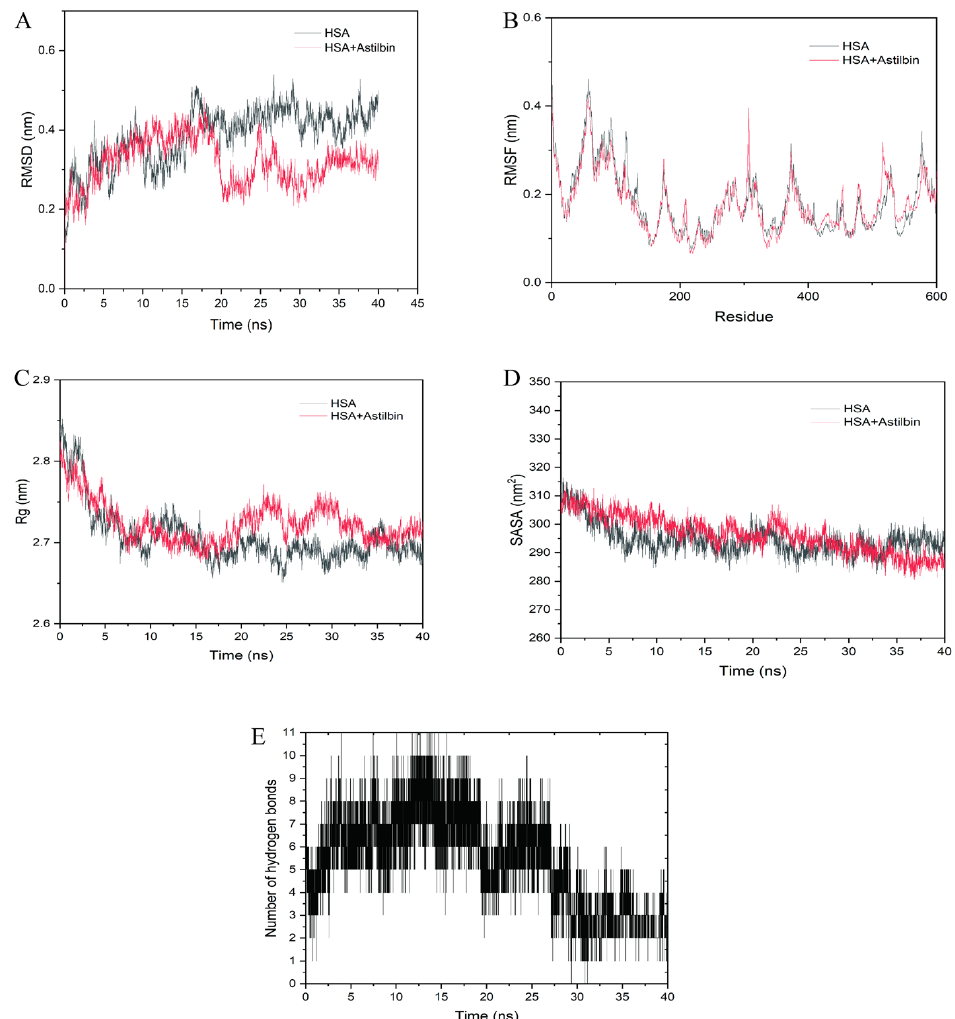
Figure 8. ( A ) The plots of RMSD, ( B ) RMSF, ( C ) Rg and ( D ) SASA of HSA − astilbin complex and free HSA. ( E ) The number of hydrogen bonds between astilbin and HSA during MD